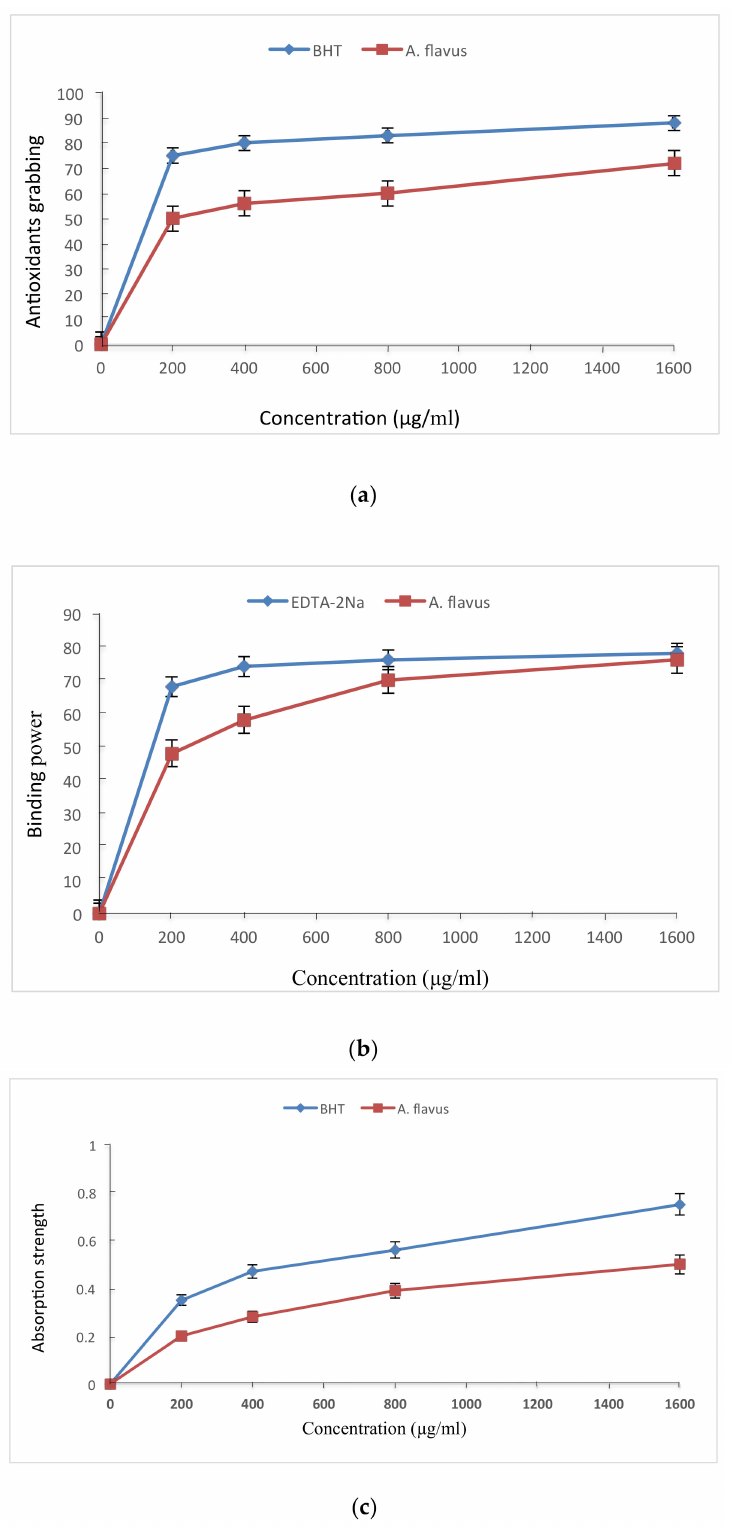
Figure 2. Antioxidant properties of fermented rice (koji) by A. flavus: ( a ) Free radical scavenging activity compared to BHT for free radical scavenger DMSO at different concentrations; ( b ) ferrous ion chelating power compared to EDTA-2Na at different concentrations; and ( c ) strength of reduction of antioxidant compounds compared to BHT at different